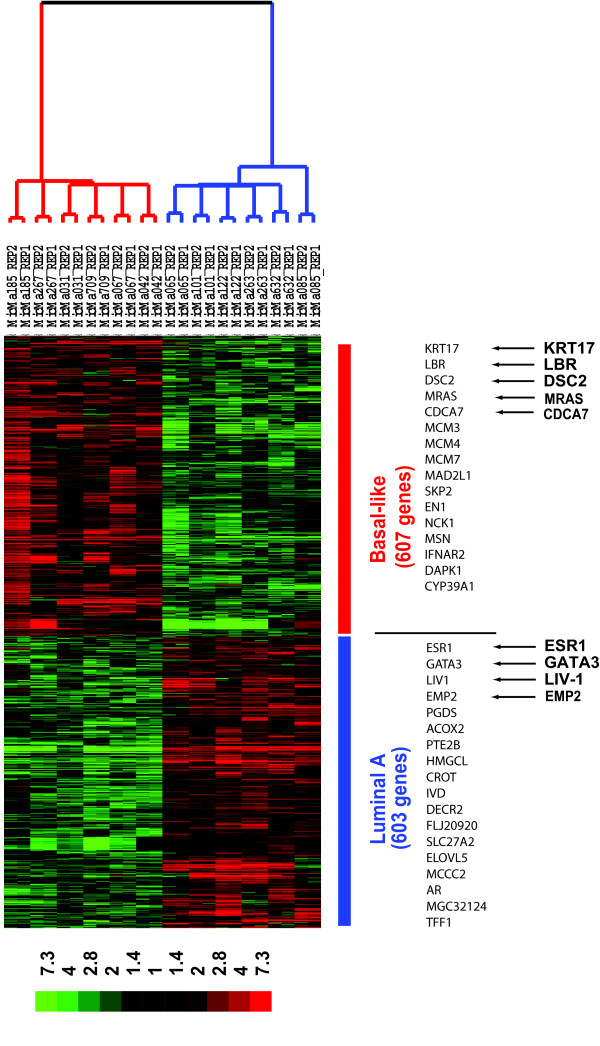
Two-dimensional cluster diagram of the 1210 signature genes characterizing the luminal A and basal-like subtypes. ANOVA analysis was performed on 6 luminal A samples and 6 basal-like samples, coupled with Benjamini and Hochberg False Discovery Rate multiple testing corrections. The two subtypes of breast tumors (two replicates per sample) were clustered into distinct clusters with reversed gene expression patterns: highly expressed in luminal A (bottom, 613 probes representing 603 genes) and highly expressed in basal (top, 631 probes representing 607 genes). The color scheme of the heat map was described in legend to Figure 1B and is shown in the key. Branches in the dendrogram are color-coded according to the subtypes: blue, luminal A; red, basal-like.